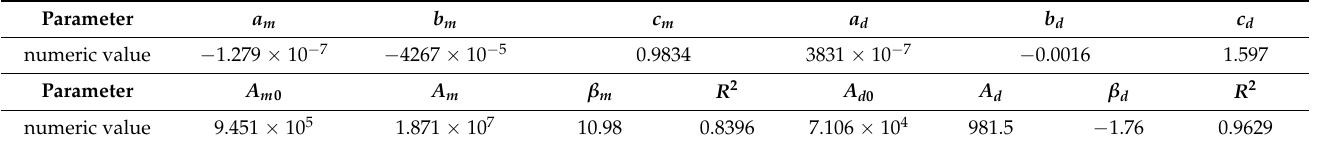
Table 3. Summary of